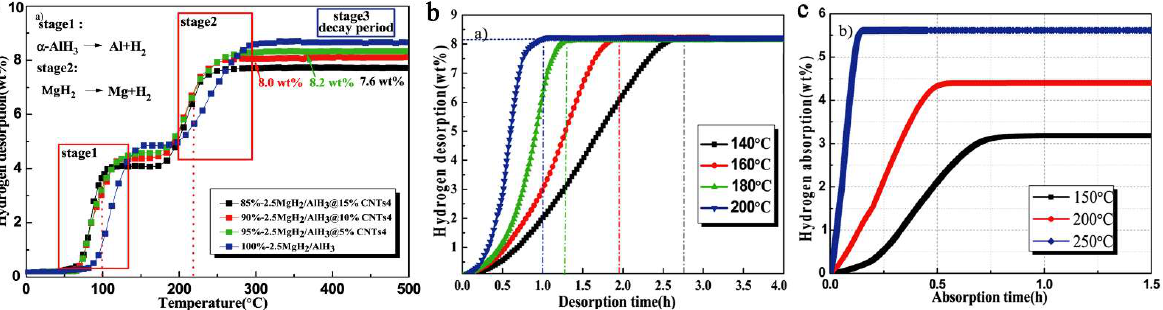
Figure 15. TPD (temperature programmed desorption) of 85%, 90% and 95%- 2.5MgH 2 /AlH 3 /CNTs4 and 100%-2.5MgH 2 /AlH 3 (ball milling, BPR 20:1, 200 rpm, 1 h) ( a ); dehydrogenation isotherm of 95%-2.5MgH 2 /AlH 3 /CNTs4 under 10 -2 Pa pressure custom vacuum system ( b ); Isothermal rehydrogenation curves of 95%-2.5MgH 2 /AlH 3 @CNTs4 at different temperatures under 5 MPa H 2 pressure ( c ) [109]. Reprinted/adapted with permission from Ref. [109]. 2021, Royal Society of Chemistry.